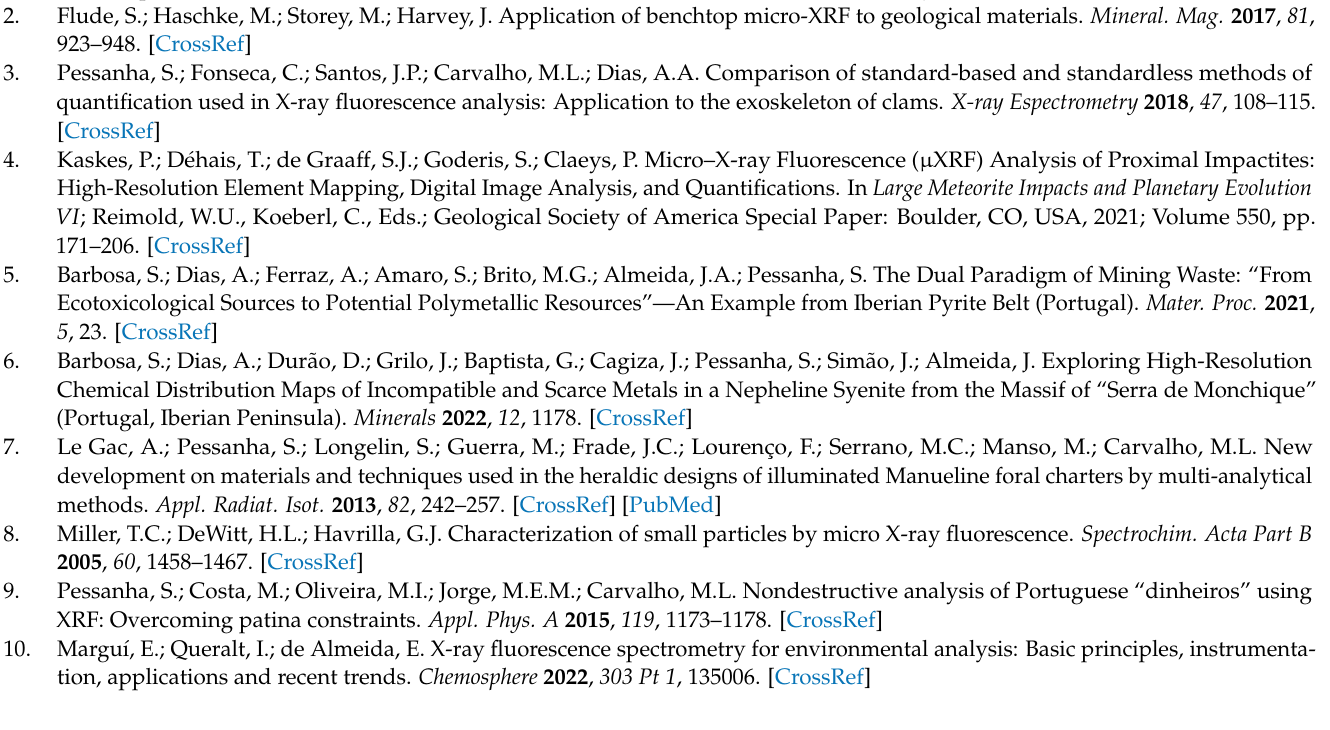
Figure A5. Minimum and maximum probable elemental occurrence in µ-XRF 2D map (percentage of area %) for As.